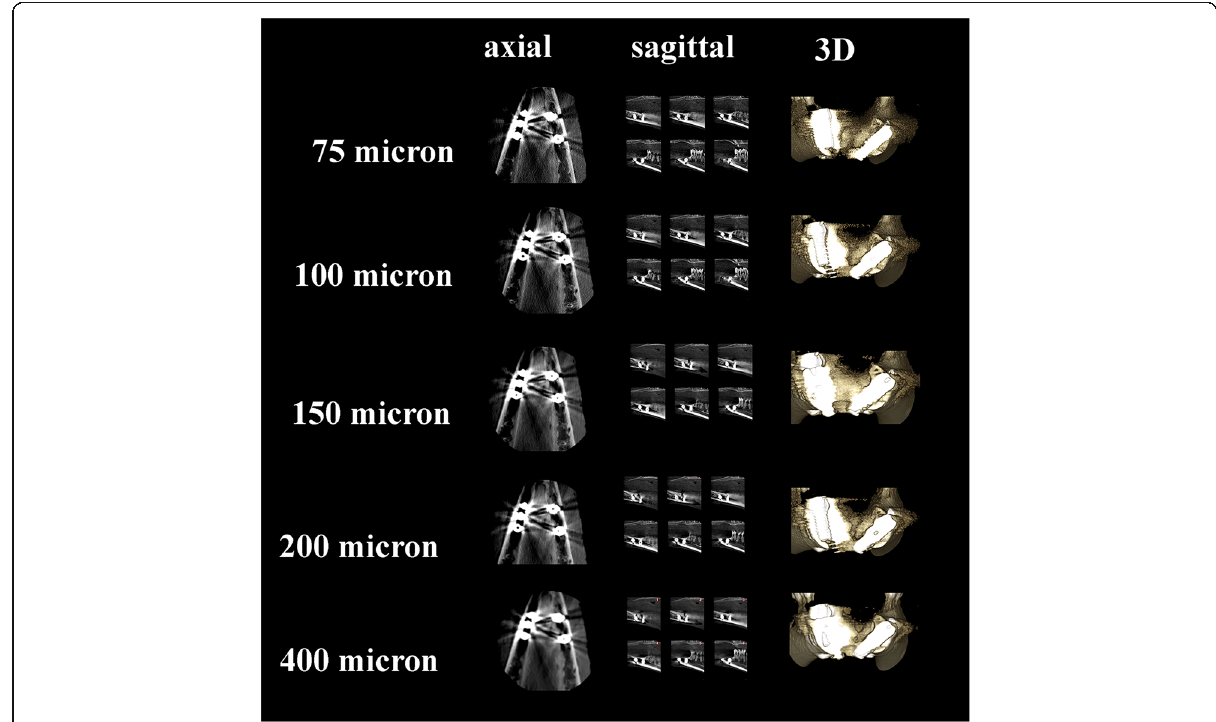
Fig. 2 Axial, sagittal, and 3D slices from CBCT images of titanium implants with simulated peri-implant fenestration defects with five voxel